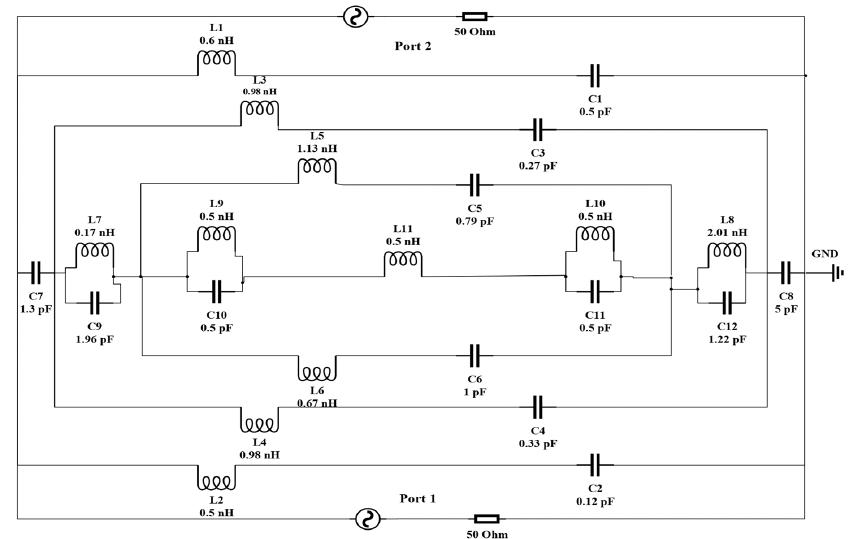
Figure 11. Equivalent electric al circuit model of the proposed metamaterial unit cell.